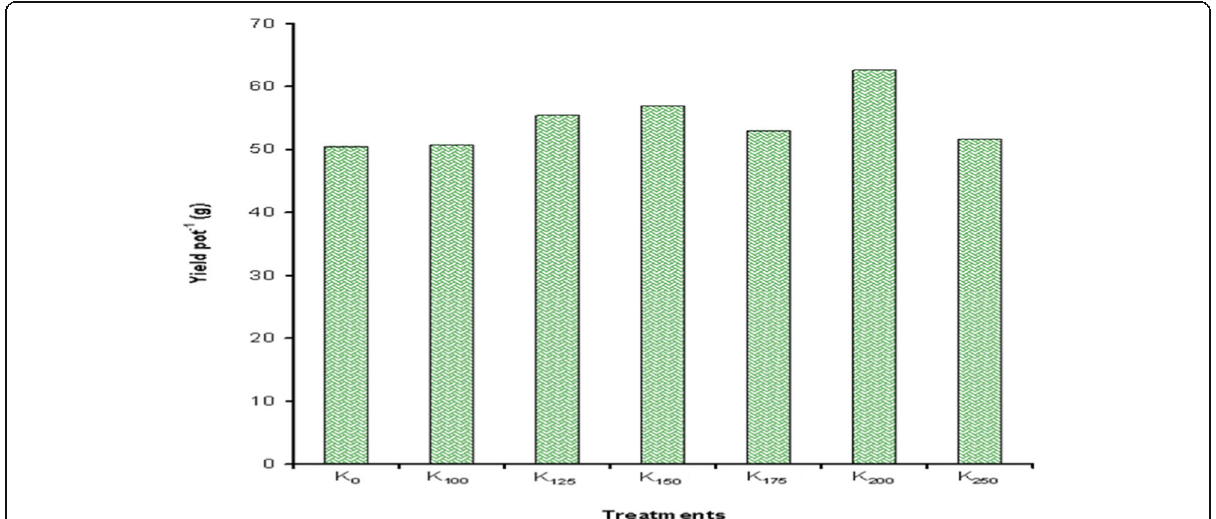
Fig. 2 Effects of potassium on the yield of garlic. K0: 0 kg K (only soil), K100: 100 kg K, K125: 125 kg K, K150: 150 kg K, K175: 175 kg K, K200: 200 kg K, K250: 250 kg K